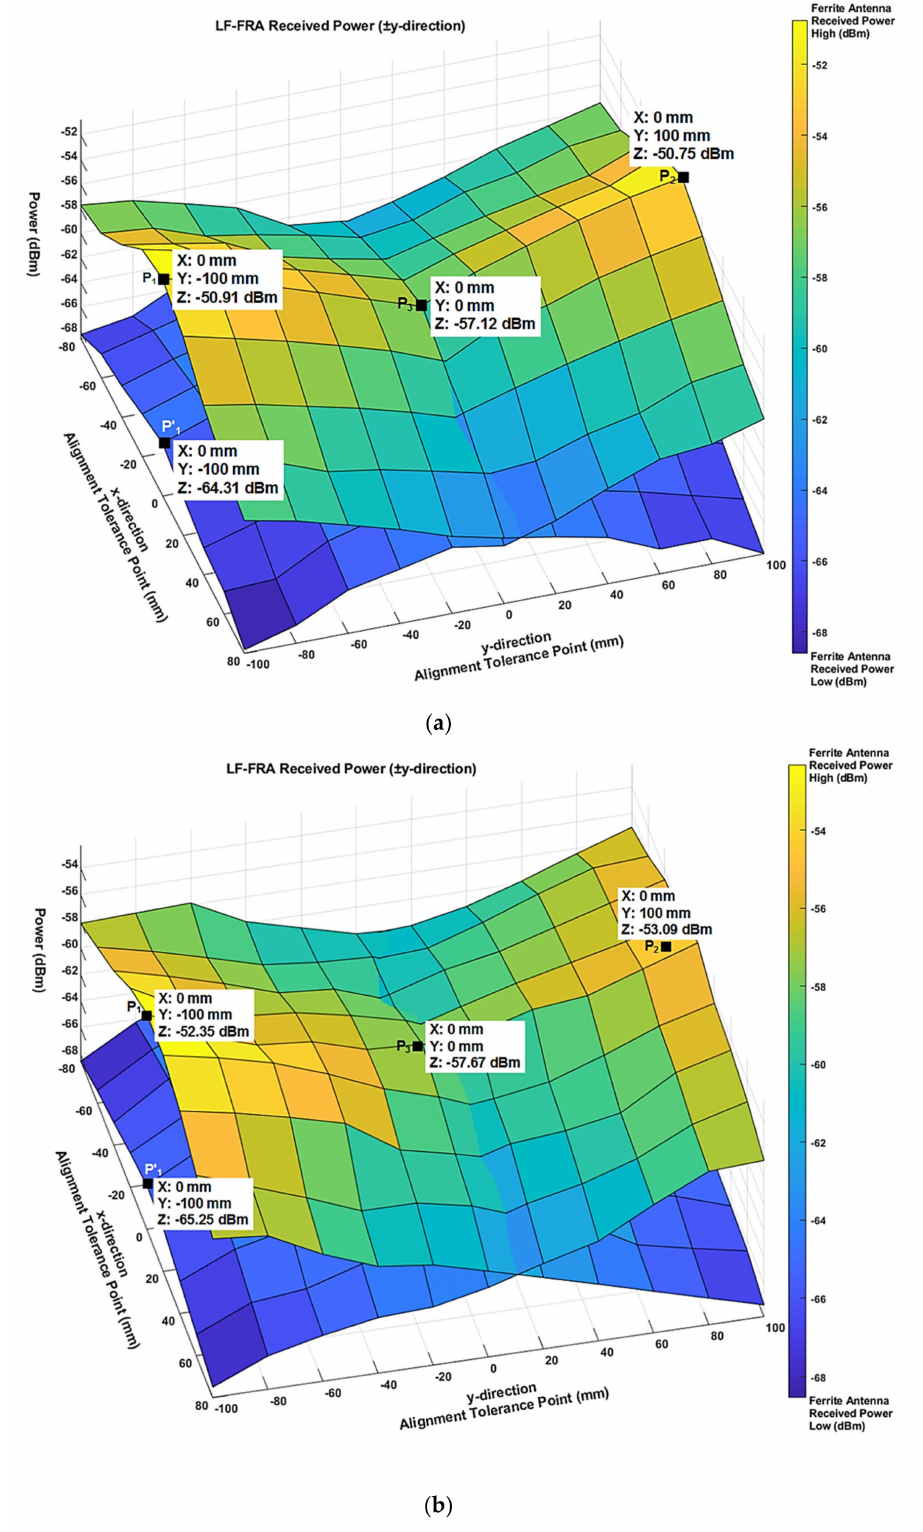
Figure 21. Experimental result for power received by the ferrite antenna receiver of the + y-direction and − y-direction. ( a ) Component level; ( b ) vehicle